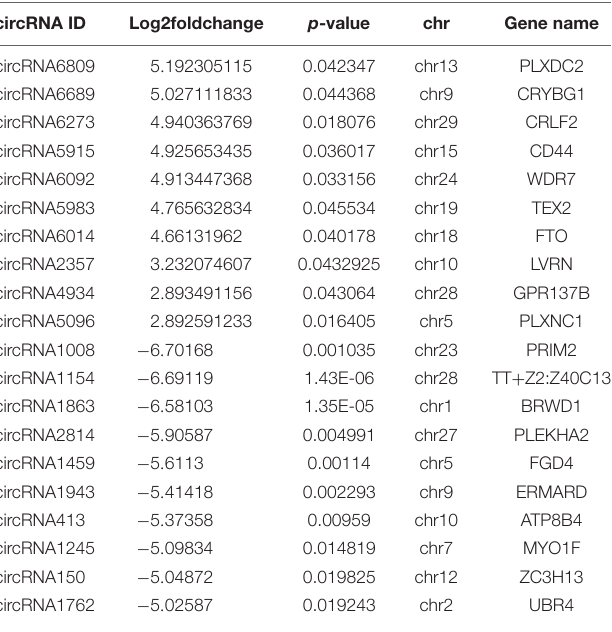
TABLE 2 | The top 20 upregulated and downregulated DE genes ( p -value ≤ 0.05) for MAP-infected vs. control MDM samples at 6 hpi as ranked by fold-change. circRNA